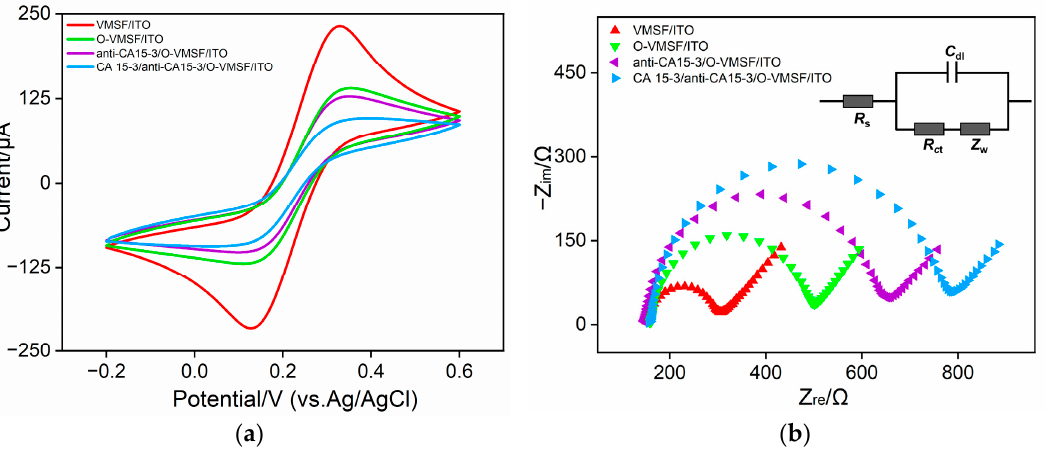
Figure 3. CV ( a ) and EIS ( b ) plots of VMSF/ITO, O-VMSF/ITO, anti-CA 15-3/O-VMSF/ITO, and CA 15-3/anti-CA 15-3/O-VMSF/ITO in a 0.1 M KCl solution containing 2.5 mM Fe(CN) 6 3 − /4 − . The scan rate in ( a ) was 0.05 V/s.